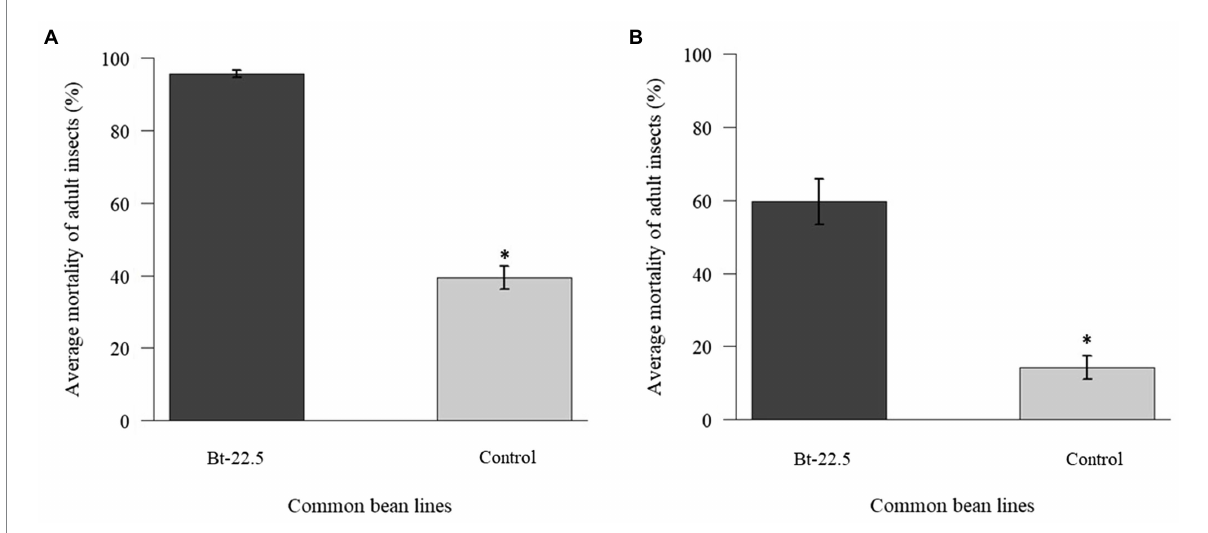
FIGURE 3 Mortality of adult whiteflies Bemisia tabaci after silencing their vATPase gene on the transgenic common bean line Bt-22.5. (A) Detached leaves ( n = 15) and (B) whole plant ( n = 10) experiments ( * p < 0.05).